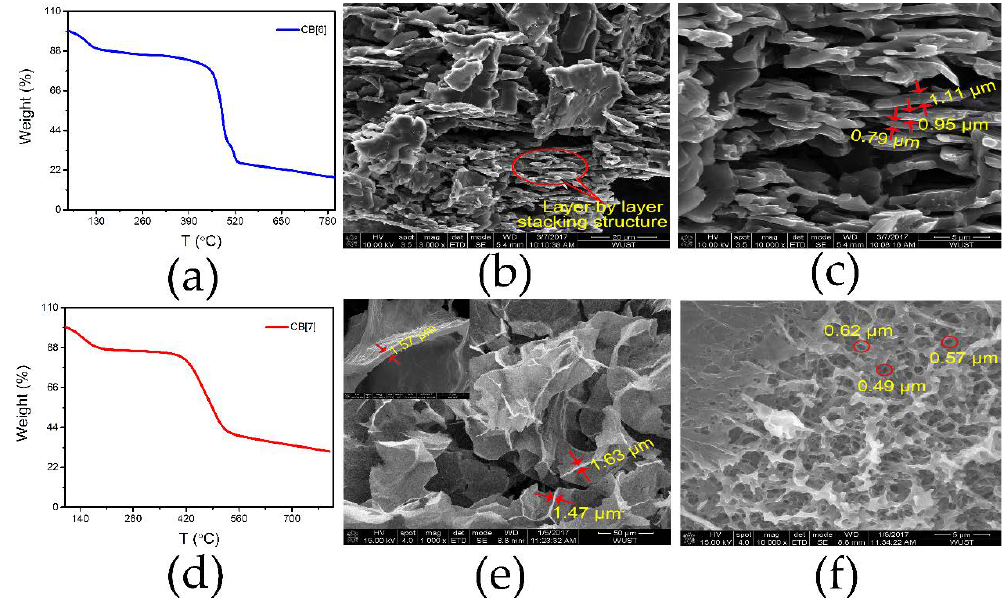
Figure 3. TGA curves of ( a ) CB[6] and ( d ) CB[7]; Secondary electron SEM images of C CB[6] : ( b , c ); Secondary electron SEM images of C CB[7] : ( e , f ). Secondary electron SEM images of C CB[7] : ( e , f